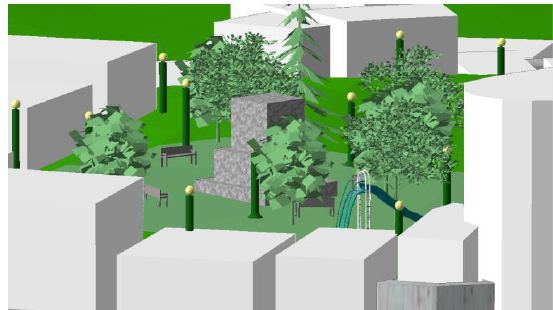
Figure 11. old town LOD2, Vegetation and City Furniture